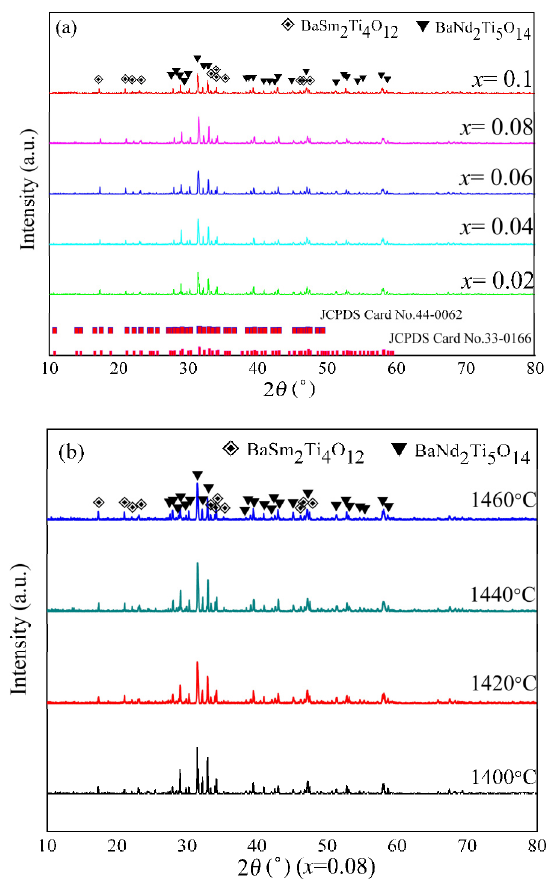
Fig. 1 XRD patterns of (Ba 1 − x Sr x ) 4 (Sm 0.4 Nd 0.6 ) 28/3 Ti 18 O 54 ceramic specimens: (a) (Ba 1 − x Sr x ) 4 (Sm 0.4 Nd 0.6 ) 28/3 Ti 18 O 54 ( x = 0.02, 0.04, 0.06, 0.08, 0.1) ceramics sintered at 1440 ℃ for 4 h; (b) (Ba 1 − x Sr x ) 4 (Sm 0.4 Nd 0.6 ) 28/3 Ti 18 O 54 ( x = 0.08) ceramic at different sintering